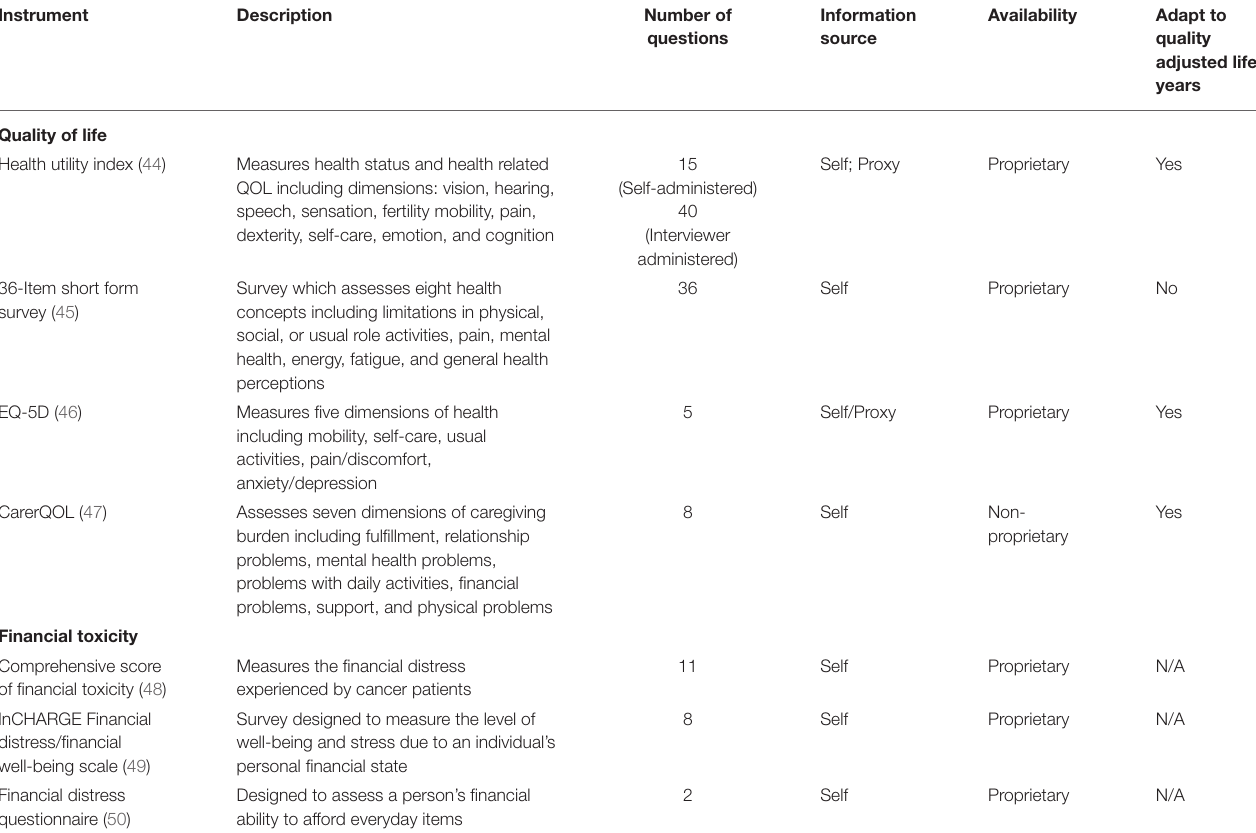
TABLE 1 | Select instruments used to measure family spillover